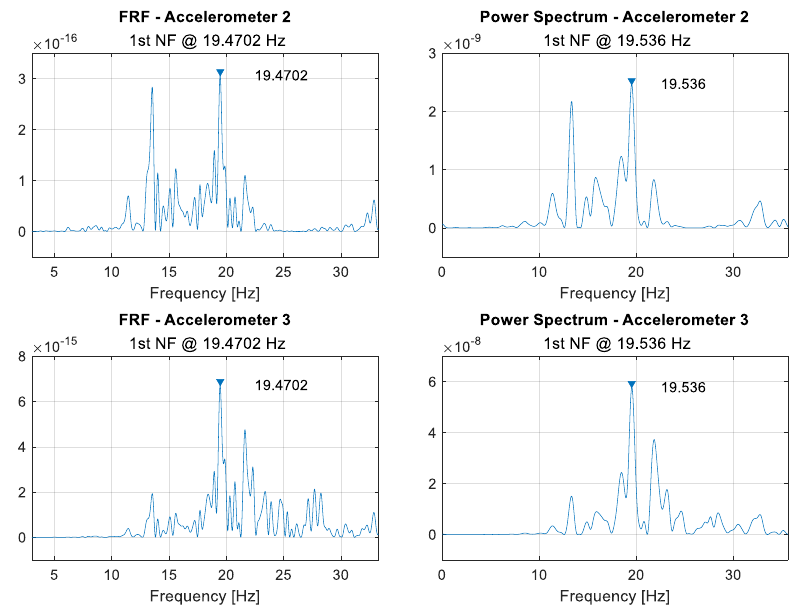
Figure A10. Arduino measurement: 1.5 revolution bolt release .